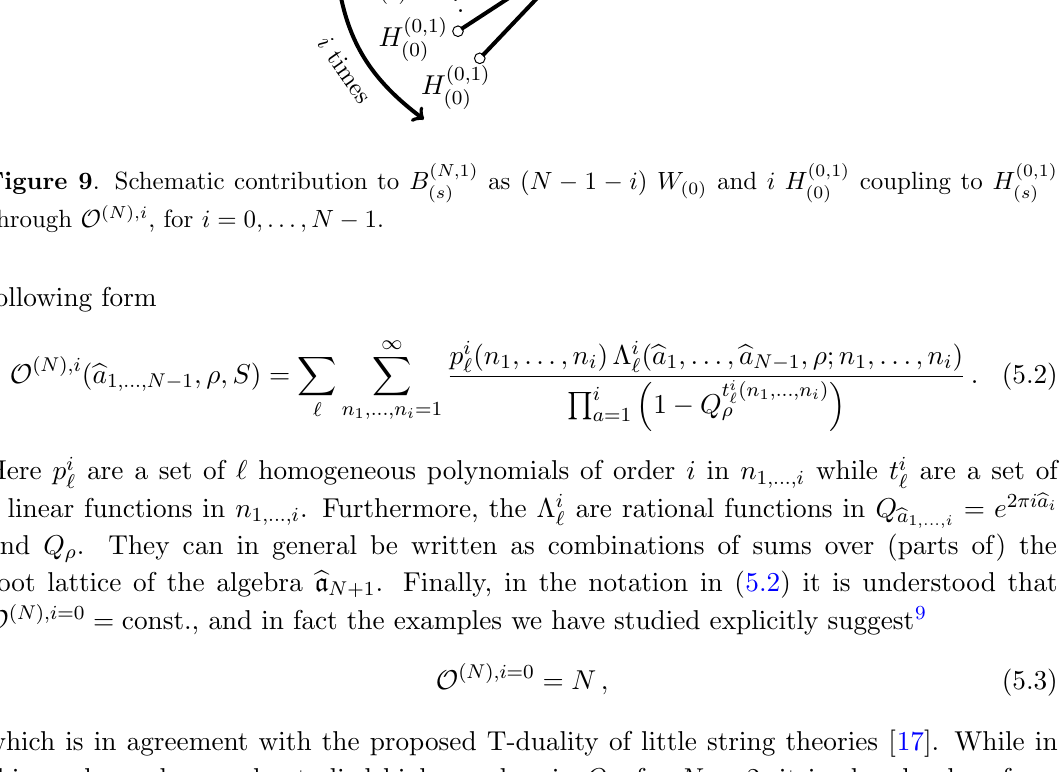
Figure 9 . Schematic contribution to B ( N; 1)